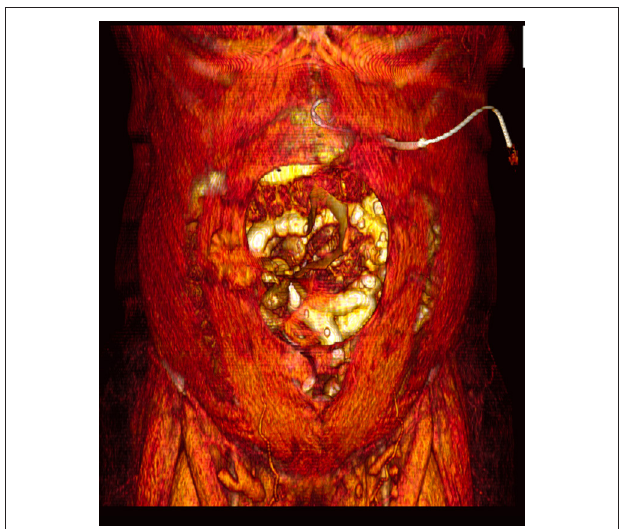
FIGURE 2 | Three-Dimensional volume rendered CT image, demonstrating site of pigtail catheter insertion.